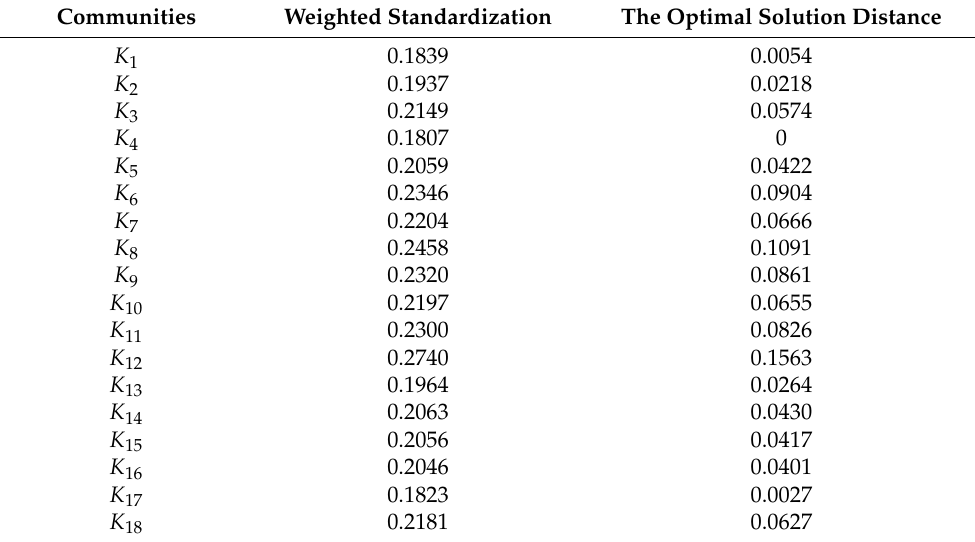
Table 8. The matrix after weighted re-standardization and the optimal solution distance of 18 communities. Communities Weighted Standardization The Optimal Solution Distance 0.1839